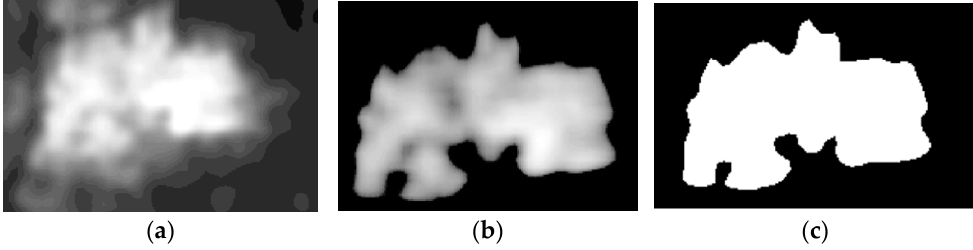
Figure 3. The process of object-level confidence calculation: ( a ) Probability distribution map output from the Softmax classifier. ( b ) Initial change detection result. ( c ) Object-level mean confidence.